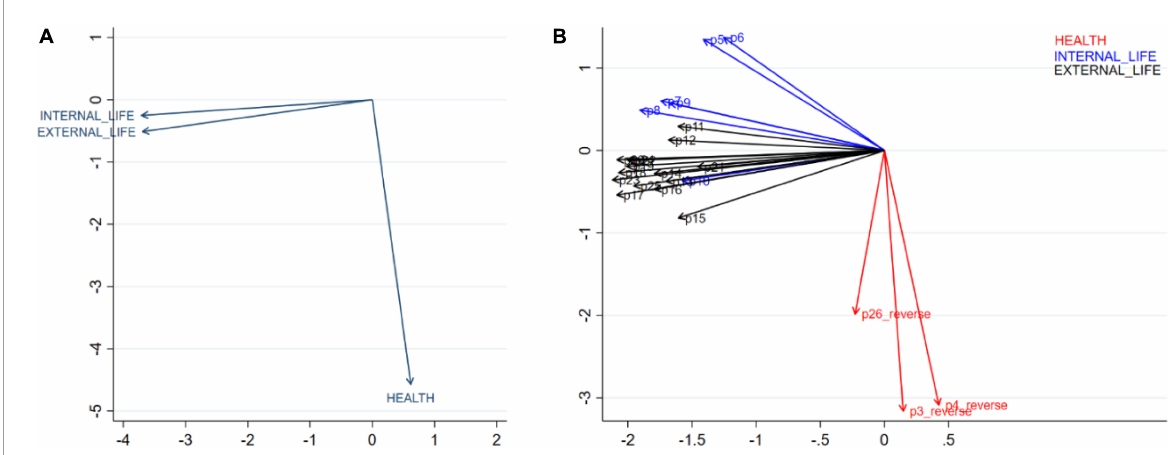
FIGURE2 Correlation between domains (A) and items (B) .